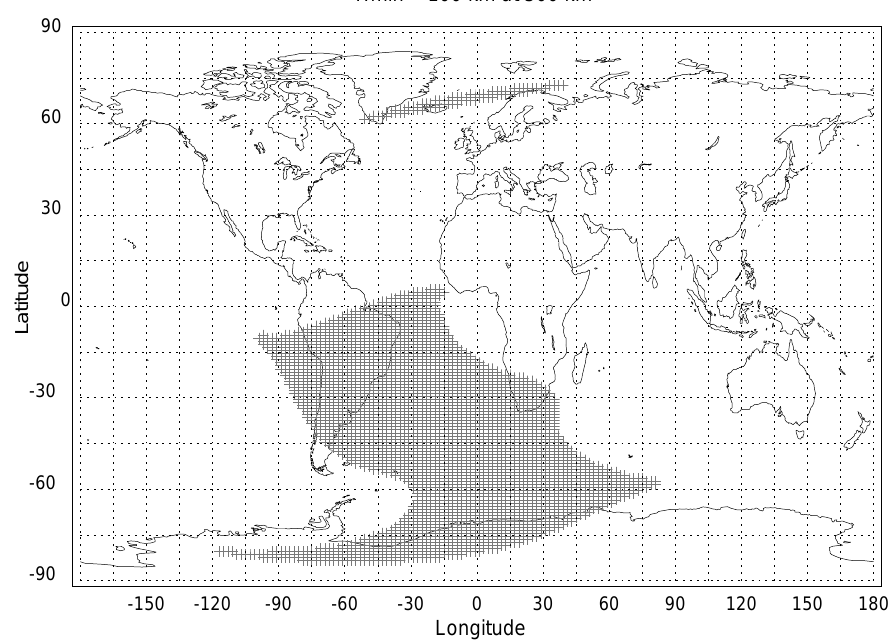
Fig. A1 The shaded areas indicate the stable trapped regions at 500km for L shells less than 8.